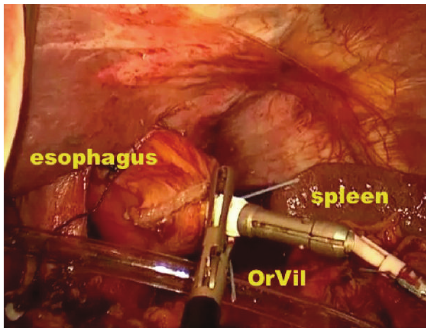
Figure 5: Appearance of the OrVil.